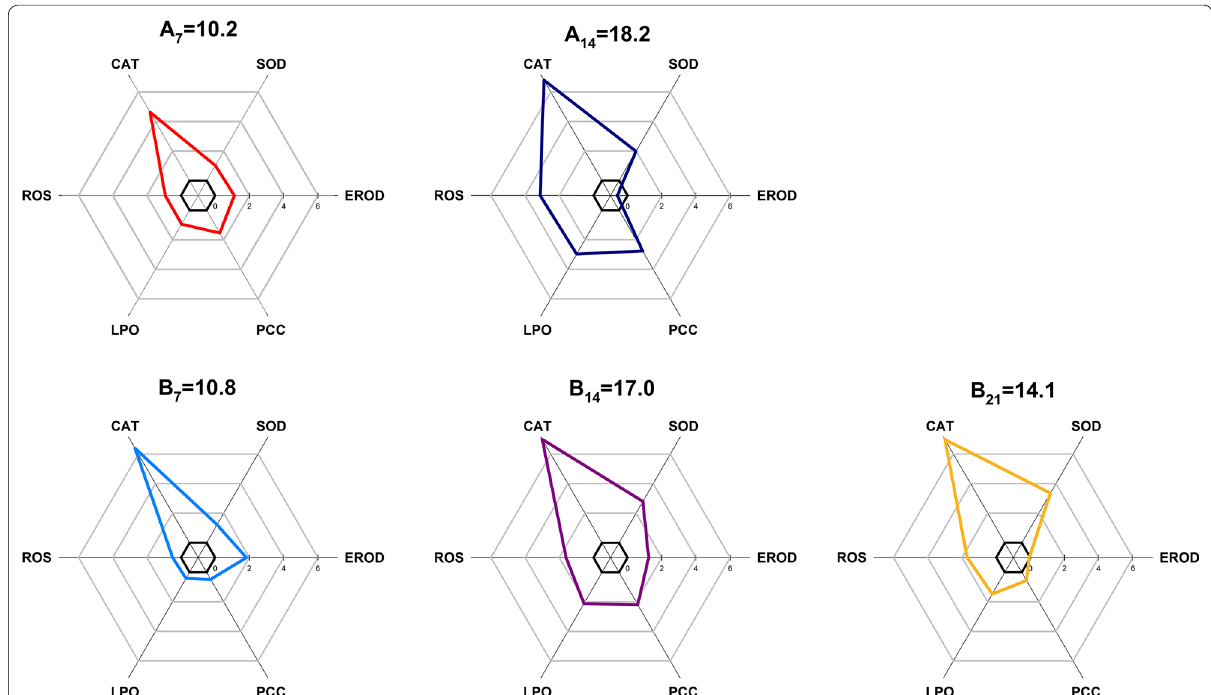
Fig. 6 Integrated biomarker responses index (IBRv2) based on the following biomarkers: ethoxyresorufin- O -deethylase activity (EROD), superoxide dismutase (SOD), reactive oxygen species (ROS), lipid peroxidation (LPO), the protein carbonyl content (PCC) and catalase activity (CAT) in the hepatopancreas tissue of Bellamya aeruginosa caged at the site A and site B of the Taihu Lake. For both sites A and B, A values calculated for each biomarker were reported in a star plot indicating the reference deviation of each investigated biomarker. Biomarker results represented in relation to the baseline group. The area above 0 reflects induction of biomarker and below 0 indicates reduction of the